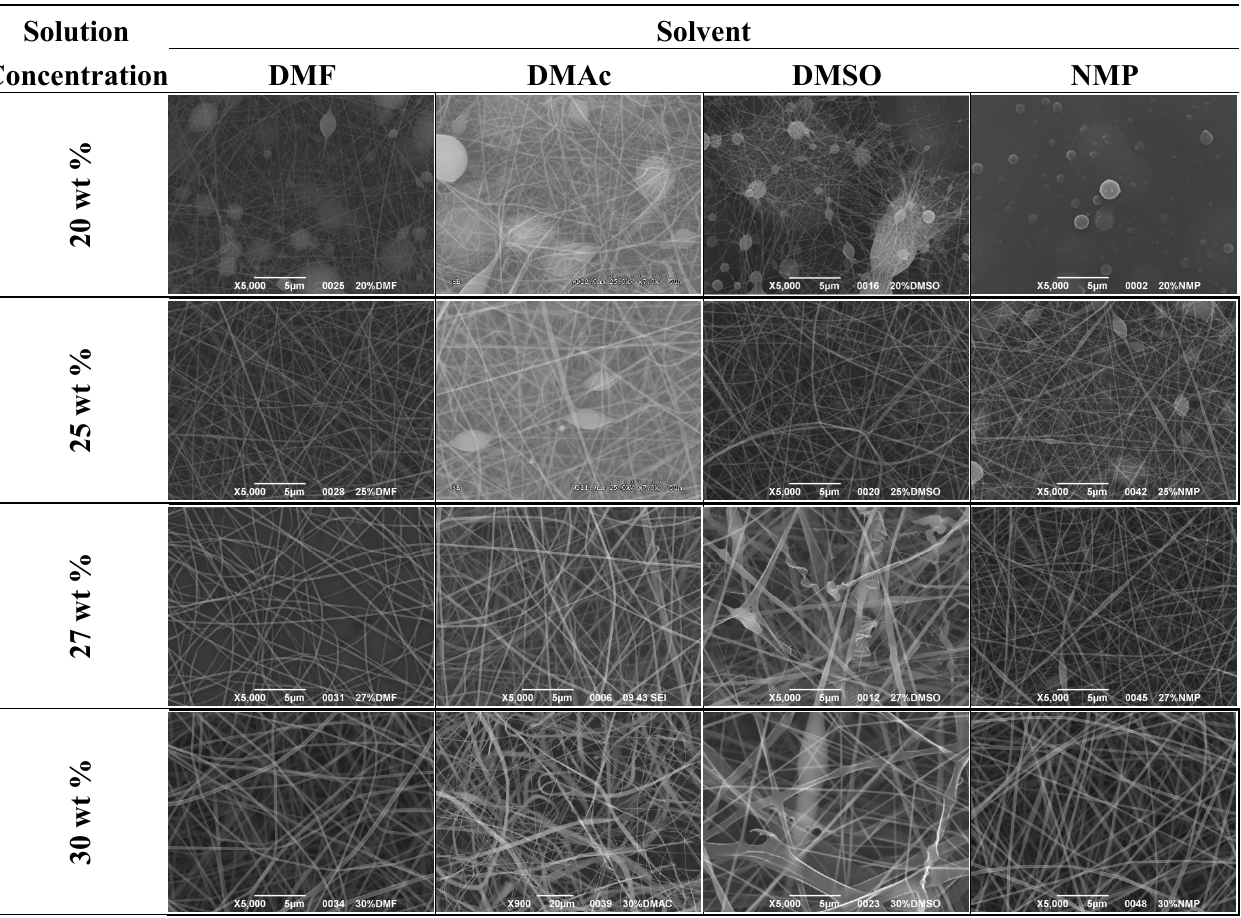
Table 3. Morphology of the electrospun samples obtained during the screening phase (sulfonation degree ≈ 70%, electrospinning condition: voltage = 20 kV, distance: 14 cm, flow-rate: 0.125